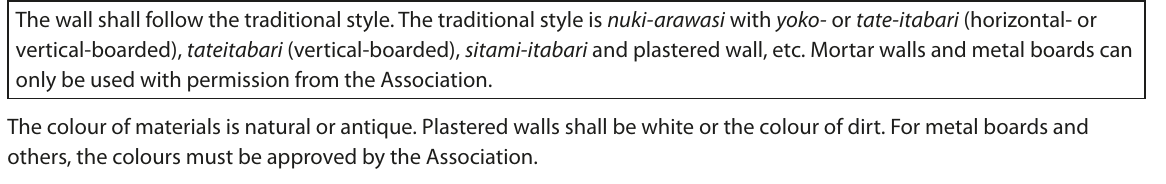
Figure 6 Preservation Rules for the Shirakawa-Mura Ogimachi Preservation District for Groups of Traditional Buildings (Source: Shirakawa mura